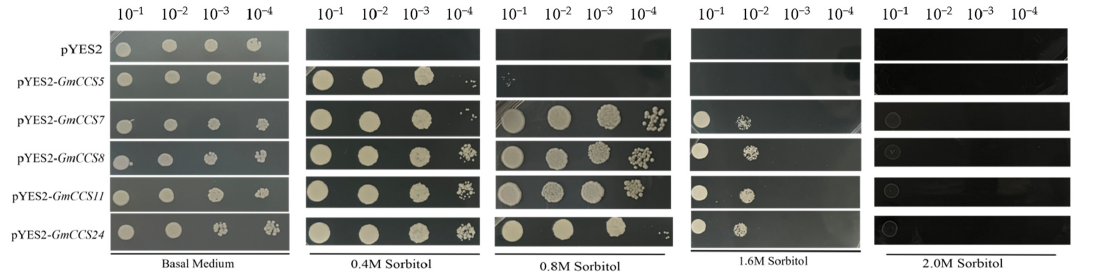
Figure 8. Drought tolerance test of candidate GmCCS genes in transformed yeast cells. 2.7. GmCCS7 and GmCCS24 Improve Drought Stress Tolerance in Transgenic Soybean